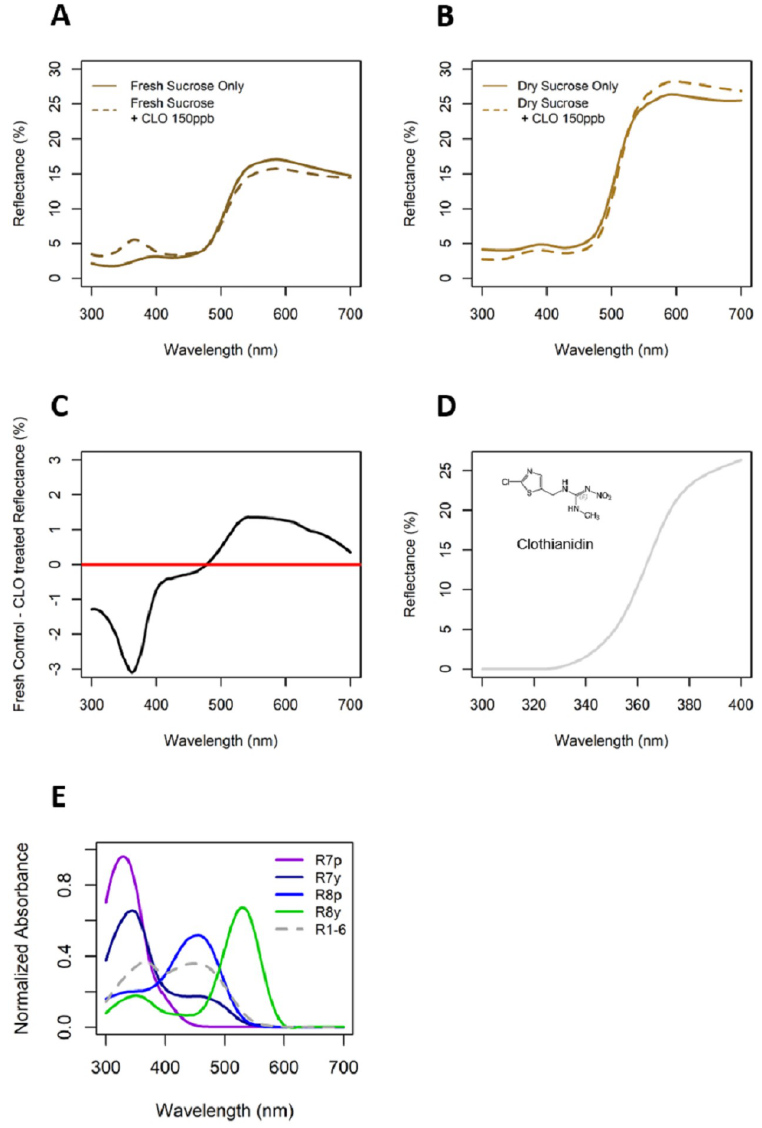
Fig 2. Hover fly-visible reflectance spectral measurements (300–700 nm). (A) freshly treated and (B) dried flower centers for sucrose only (solid) and sucrose + 150 ppb clothianidin (dashed line) treatments. (C) Difference in reflectance spectra of fresh sucrose only (control) vs. sucrose + 150 ppb clothianidin. (D) Ultraviolet reflectance spectra (300–400 nm) of pure clothianidin powder against black optical aluminum foil ( < 3% reflectance across all 300–700 nm). (E) Eristalis tenax photoreceptor sensitivities as normalized absorbance curves [19, 45].